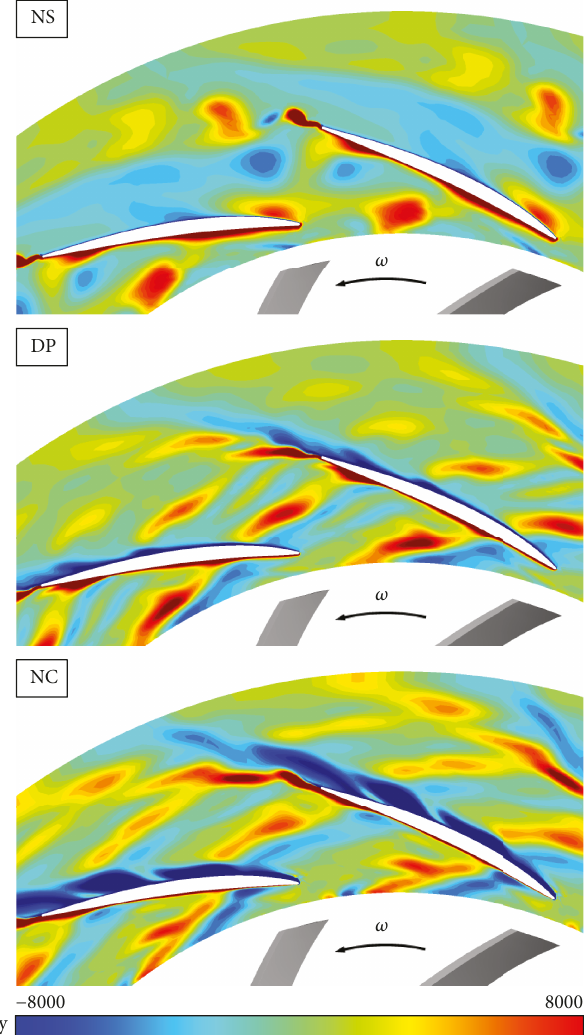
Figure 20: Vortical structures in the vaned di ff user at the